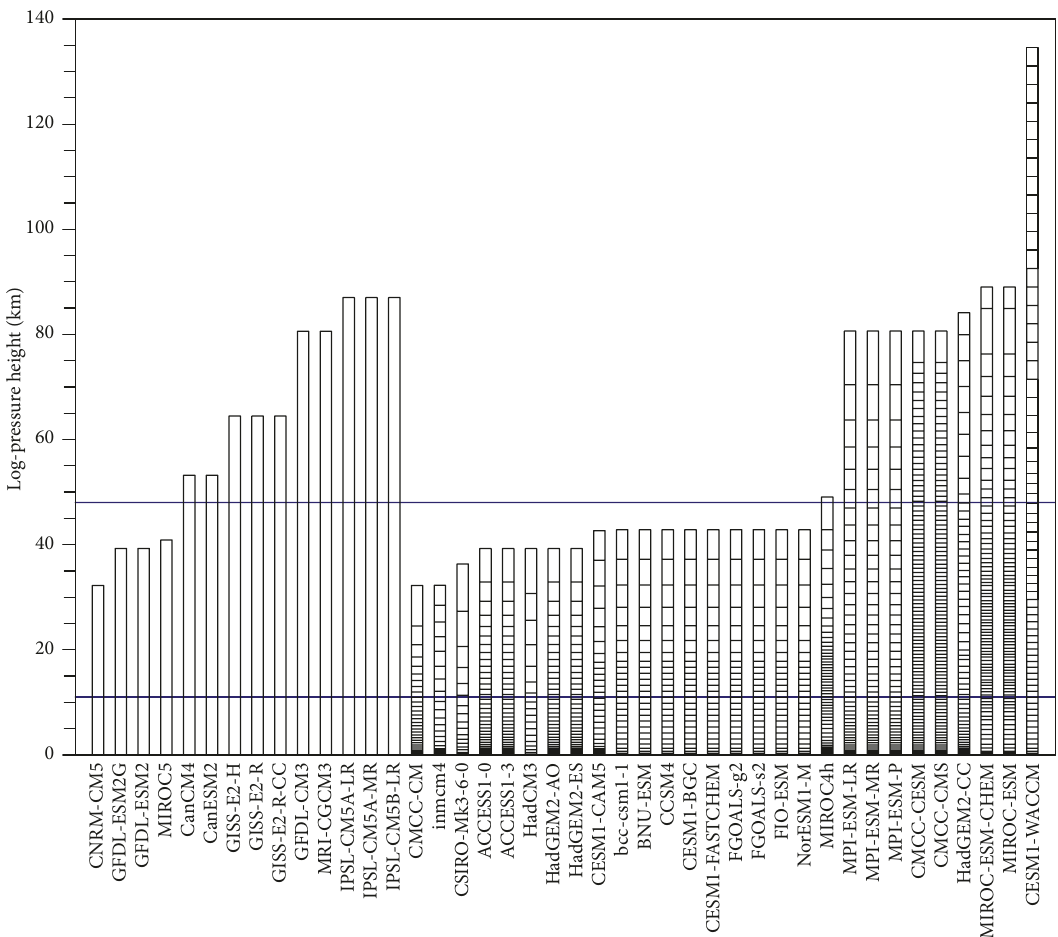
Figure 1: The vertical coverage and layers of the 42 CMIP5 models used in this study, with the blue lines indicating the tropopause and stratopause. The overall height of a box represents the altitude of the atmospheric model top and the solid lines in the boxes indicate the altitudes of the vertical layers. The 14 leftmost models are lacking specific layer